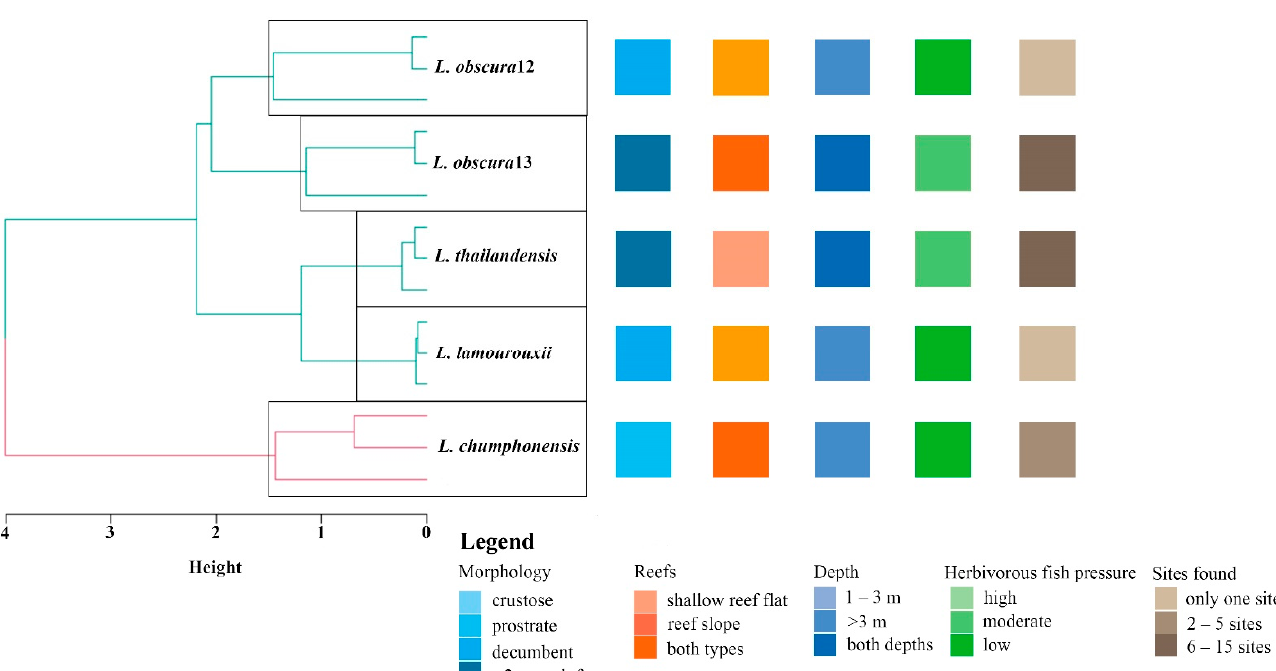
Figure 3. Hierarchical cluster analysis of Lobophora species by using morphology, thallus thickness, height, length, and width as predictors. Reef types, depth, herbivorous fish pressure, and sites found were not used to analyze hierarchical cluster. Reefs and depth presented where the Lobophora can be found. Herbivorous fish pressure categorized by the abundance of herbivorous fish occurs in areas. The number of sites found is shown.